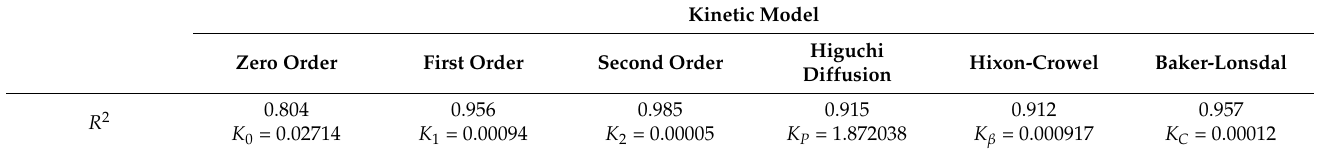
Table 2. Parameters and R 2 values of each kinetic model for estimating the release of LNZ from (1:1) LNZ–BCDs